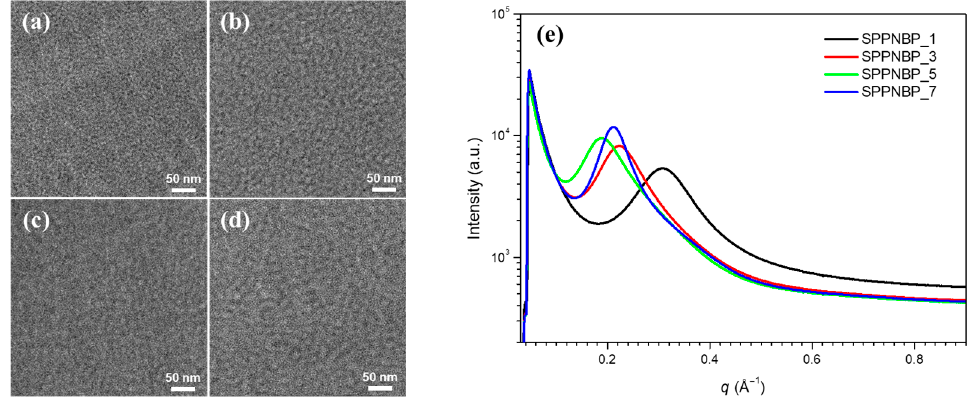
Figure 3. TEM images of ( a – d ) SPPNBP membranes, and ( e ) SAXS intensity profiles. Proton conductivity ( σ ) of a PEM is one of the key parameters determining PEMWE performance and is mainly affected by IEC and membrane morphology [37]. The proton conductivities of SPPNBP membranes were measured at 80 ◦ C. As expected, the σ values in- creased with IEC and WU (Figure 4a). SPPNBP_1, which has the lowest IEC, 1.10 meq g − 1 , shows σ = 0.046 S cm − 1 , but the conductivity increases to σ = 0.152 (SPPNBP_3) and 0.200 S cm − 1 (SPPNBP_5). For SPPNBP_5, the proton conductivity was comparable to Nafion 212 and was the highest in the SPPNBP series. With the NBP blocks, high IEC is necessary to have the comparable σ value of Nafion 212 ( σ = 0.196 S cm − 1 ), compared to other SPP based multi-block copolymers. The inclusion of rigid and planar naphthalene units in the copolymers is advantageous as it helps to impede changes in the dimensions of liquid water [33]. However, the incorporation of hydrophobic blocks based on naphthalene results in a slight reduction in proton conductivity, as it decreases the amount of water uptake. When comparing SPPNBP_7 to SPPNBP_3, it is likely that the wider hydrophilic domains in SPPNBP_7 contributed to the higher σ value of 0.177 S cm − 1 .